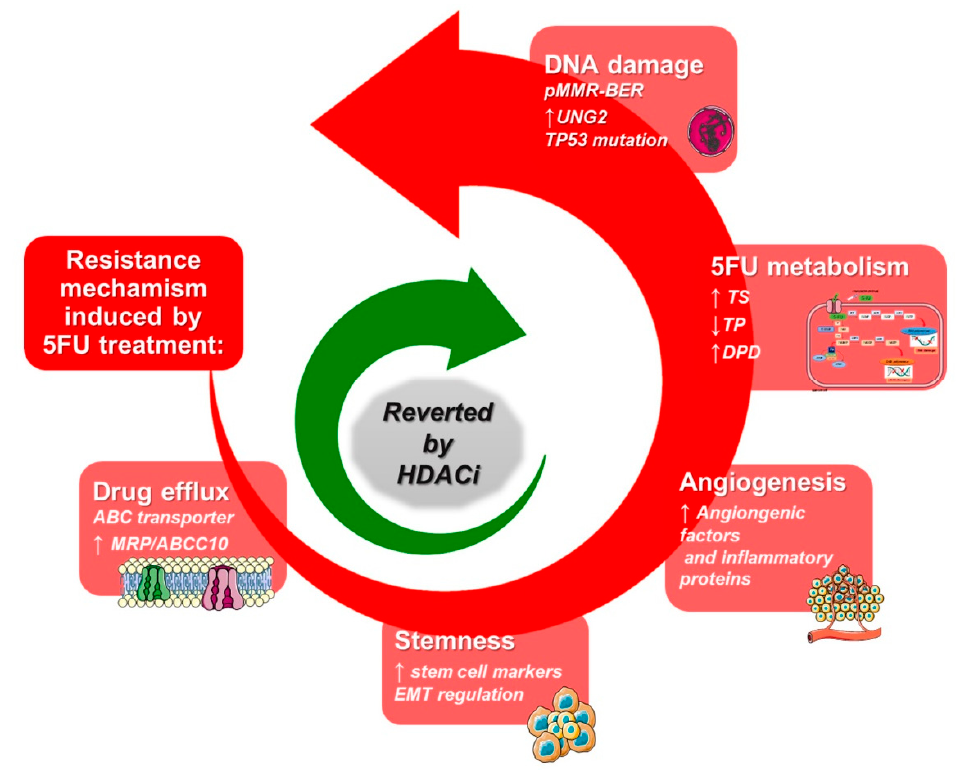
Figure 4. Mechanisms of overcoming fluoropyrimidines drug resistance by HDACis. Red arrow connects the mechanisms by which cancer cells acquire resistance to fluoropyrimidines, whereas green arrow indicates that the treatment with HDACis could act on these mechanisms reverting the resistance and sensitizing cancer cells to chemotherapy treatment.